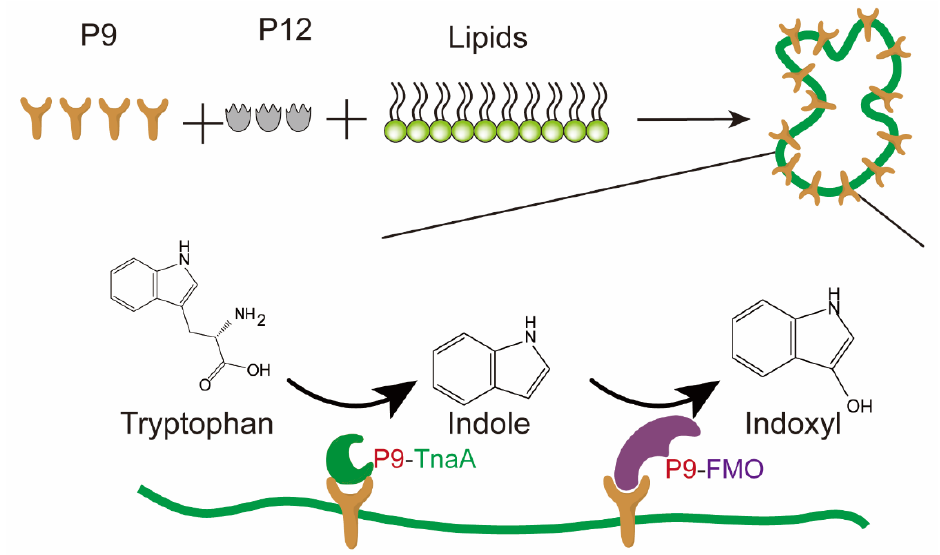
Figure 4. Schematic diagram of enzyme assembly by using a lipid-containing scaffold. Indigo production was chosen as an example to show the fixation mode between a lipid-containing scaffold and enzymes (tryptophanase TnaA and flavin-dependent monooxygenase FMO). Both TnaA and FMO were fused with P9.